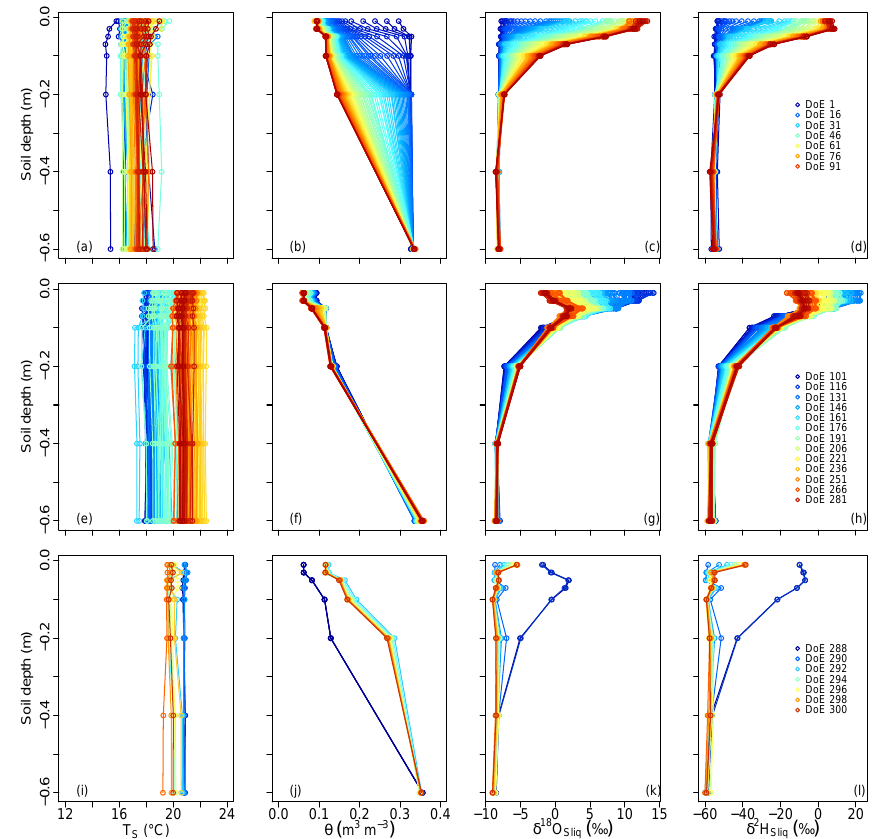
Figure 5. Soil temperature ( T S ), water content ( θ ), and liquid water isotope compositions ( δ 18 O Sliq and δ 2 H Sliq [‰ VSMOW]) profiles from day of experiment (DoE) 0–100 (top panel), from DoE 101–287 (middle panel), and from DoE 288–299 (bottom panel).